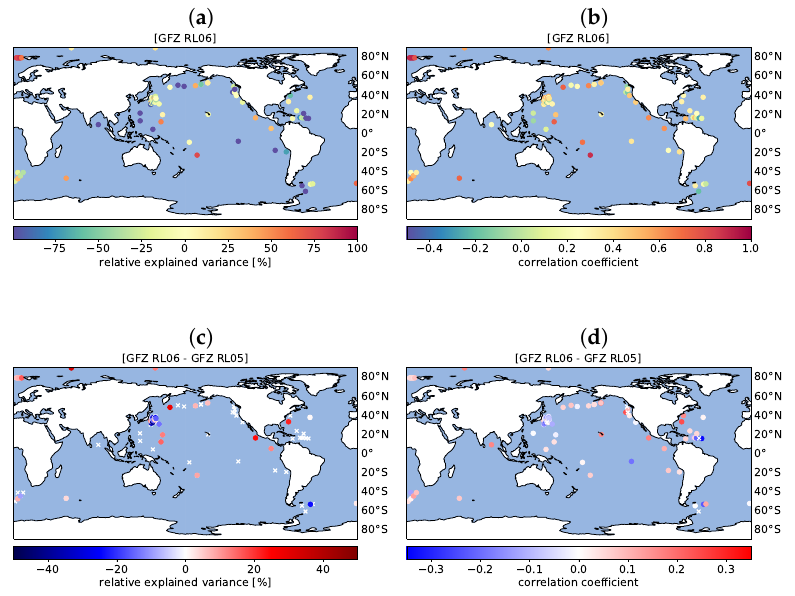
Figure 8. ( a ) Relative explained variances σ 2 r at in situ OBP stations for GFZ RL06; ( b ) Correlation coefficients between in situ OBP and GRACE OBP for GFZ RL06; ( c ) Difference of relative explained variances for GFZ RL06 and GFZ RL05a; ( d ) Difference of correlation coefficients for GFZ RL06 and GFZ RL05a. For ( c ) and ( d ), red colors indicate improvements of GFZ RL06 over GFZ RL05a; stations with relative explained variances or correlation coefficients < 0 for both RL06 and RL05a are marked with white